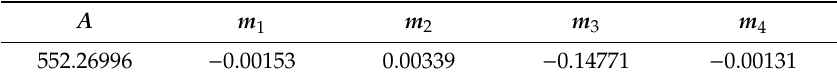
Table 2. Values for the parameters of the Hensel Spittel equation for X45CrSi9-3 (1.4718).